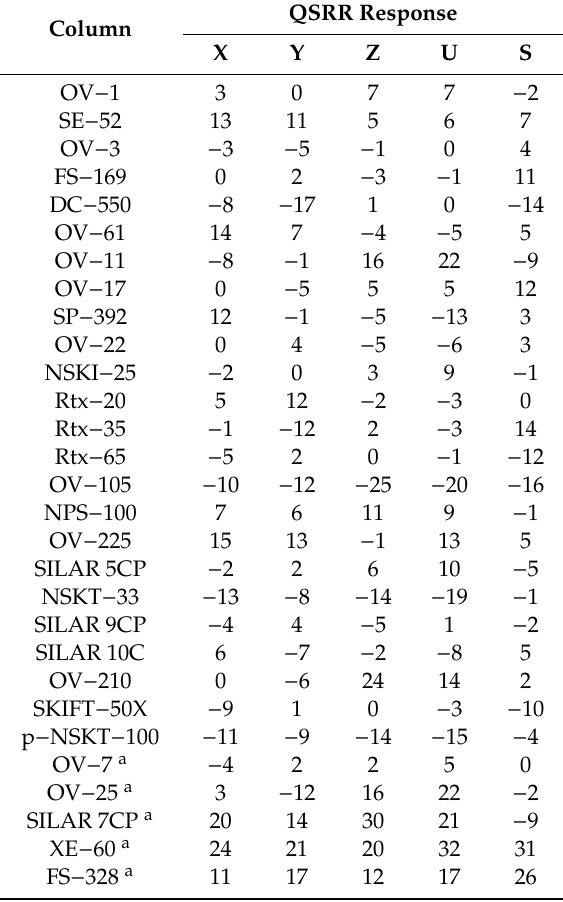
Table A2. Calculated and predicted residuals of the QSRR